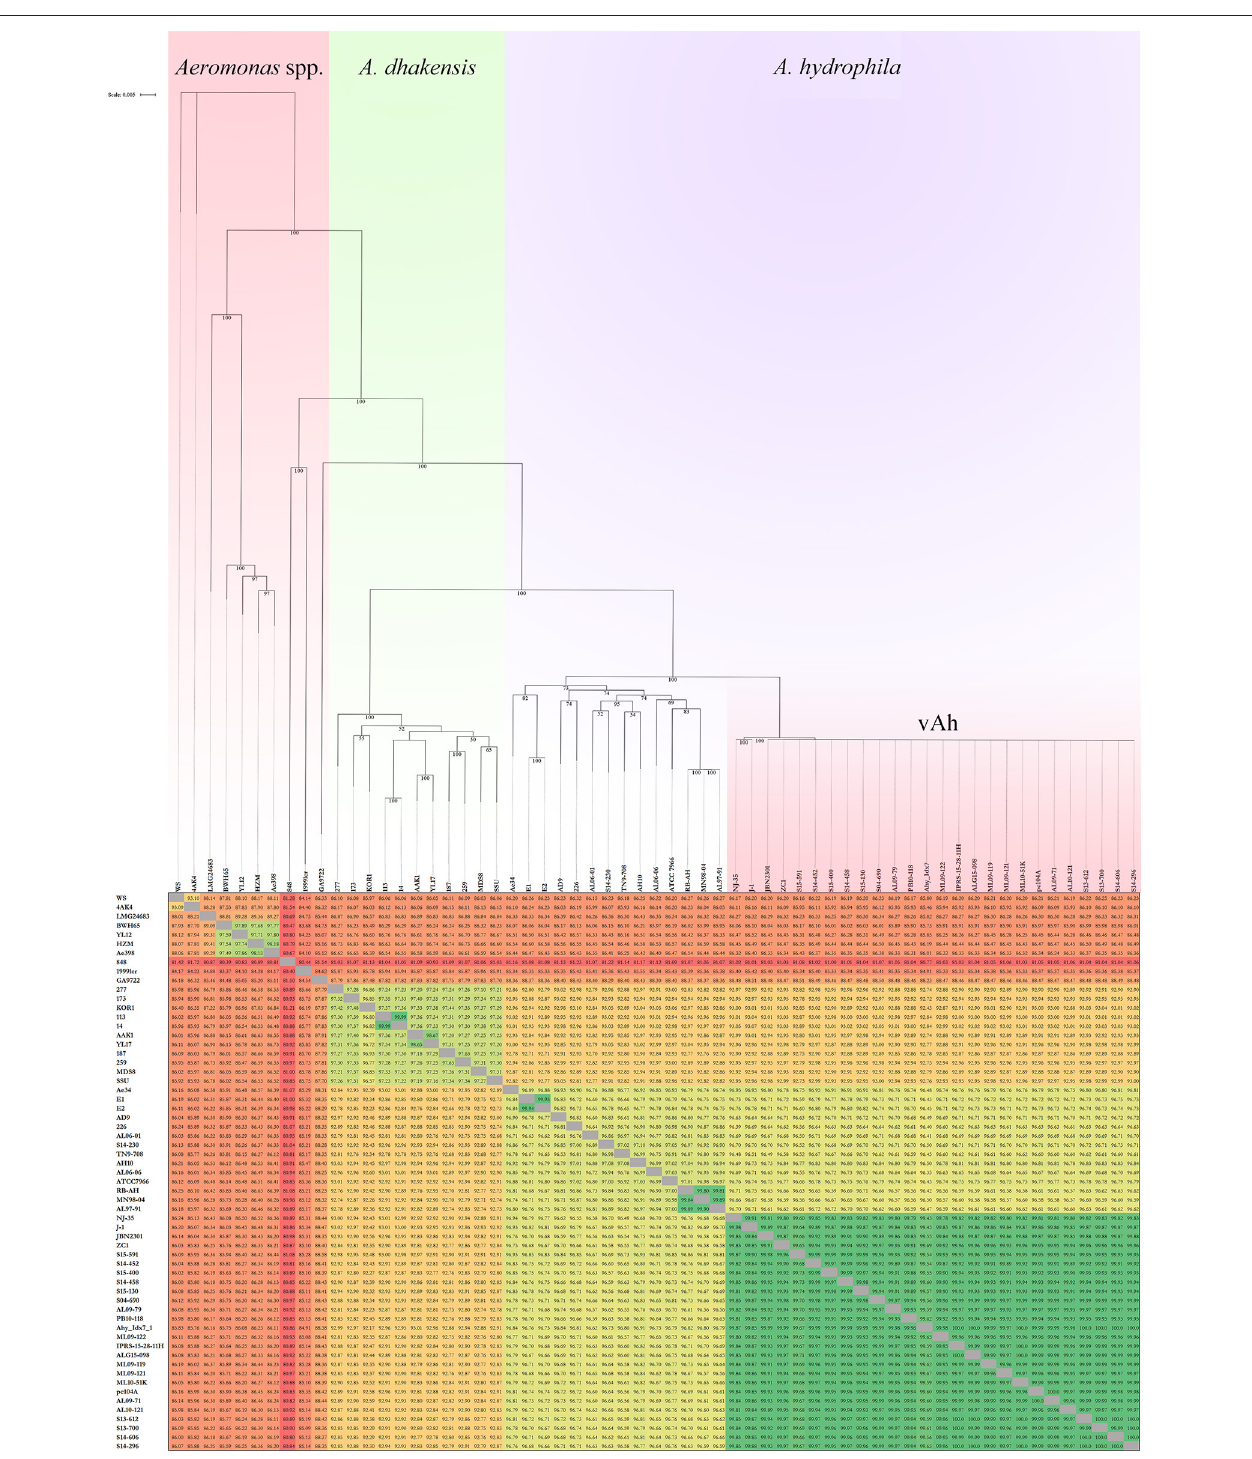
FIGURE 3 | Average nucleotide identities (ANI) among Aeromonas spp. strains and an associated maximum likelihood phylogram based on a core genome phylogeny (Figure 1). Please note that the branch length of strains 848 and 1999lcr were reduced to improve readability and pairwise ANI-values are color-coded according to percent